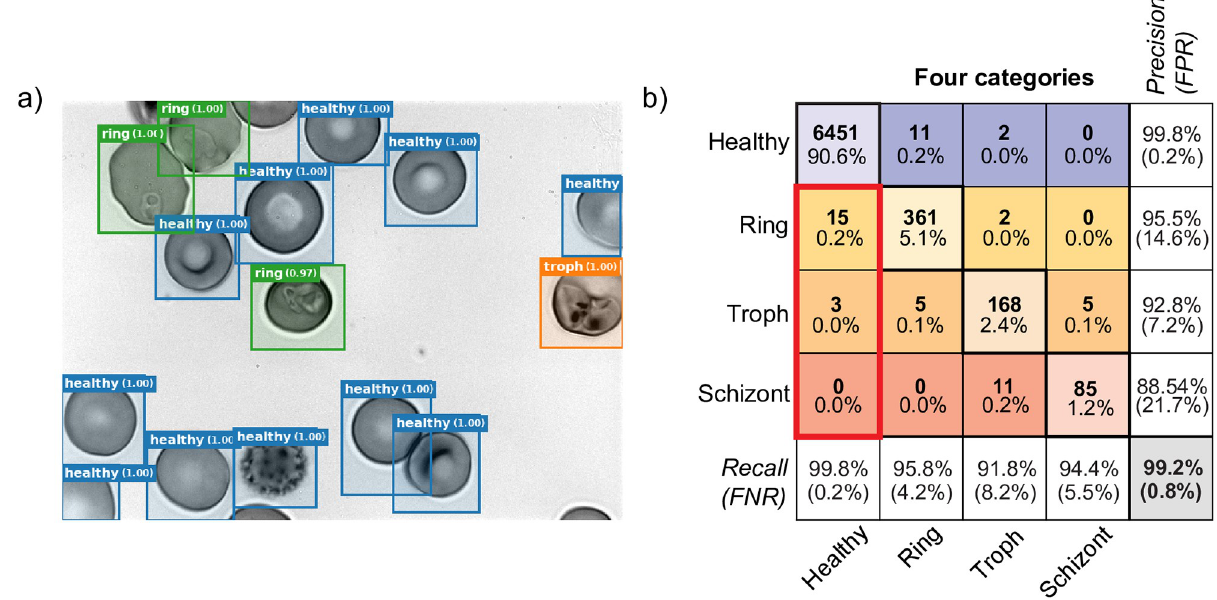
Fig 7. Faster R-CNN classifier. a) The Faster-RCNN method detects objects directly on images without using an intermediate semantic segmentation step [45], generating bounding boxes and confidence scores for each detected object. The image shown was acquired at 285 nm, and includes examples of healthy cells, ring stage parasites, trophozoites, as well as an echinocyte (spiky RBC, lower middle-left). b) A four-category confusion matrix is shown for the Faster R-CNN method, using the same format as in Fig 2. Faster R-CNN exhibited a reduced FPR and higher overall accuracy than the two-step